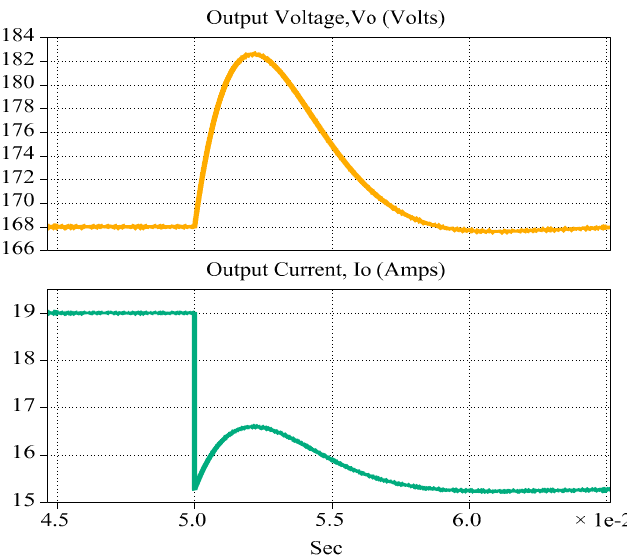
Figure 9. Simulation results for step change in load.